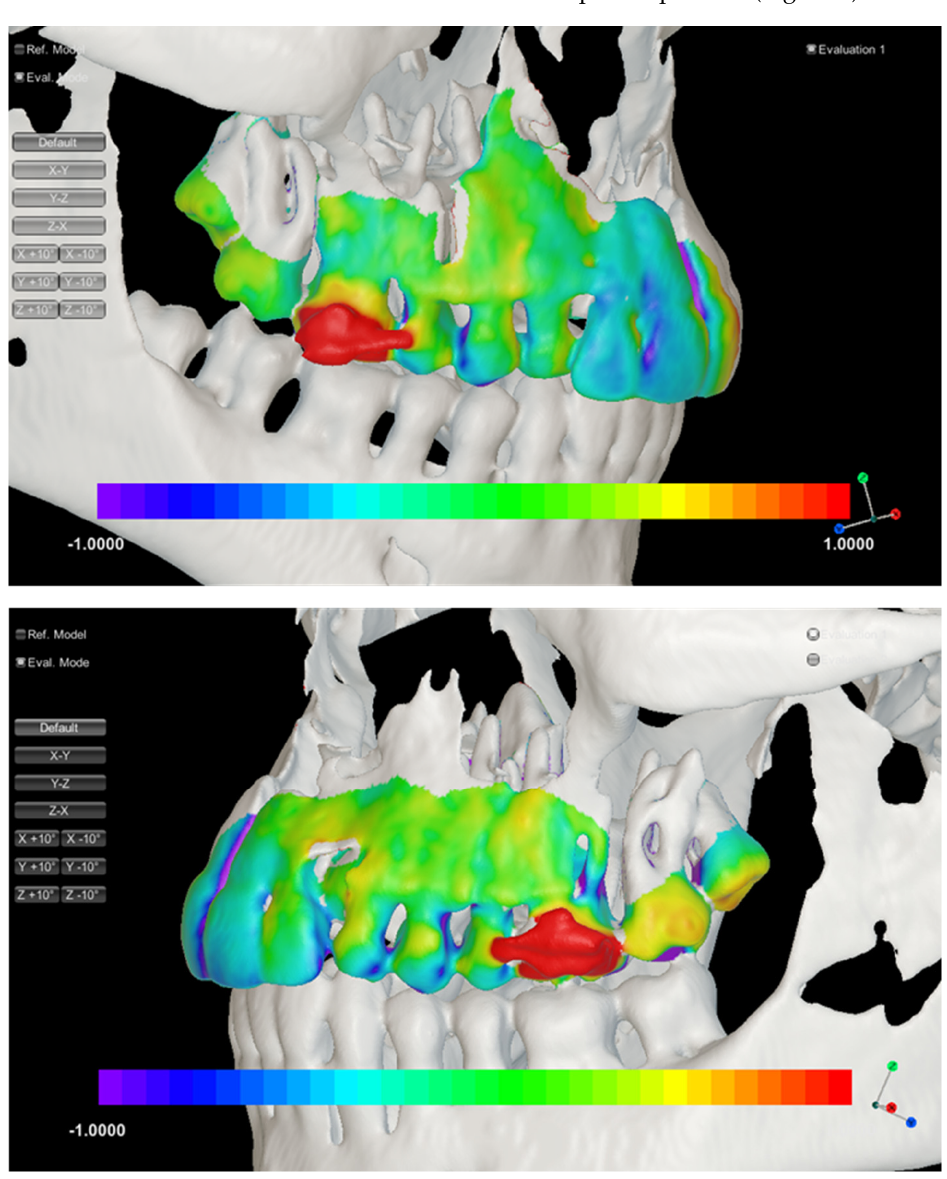
Figure 6. Three-dimensional visualization and color mapping of tooth movement after expansion in the left and right side. The blue color indicates palatal tipping and the red color buccal tipping.